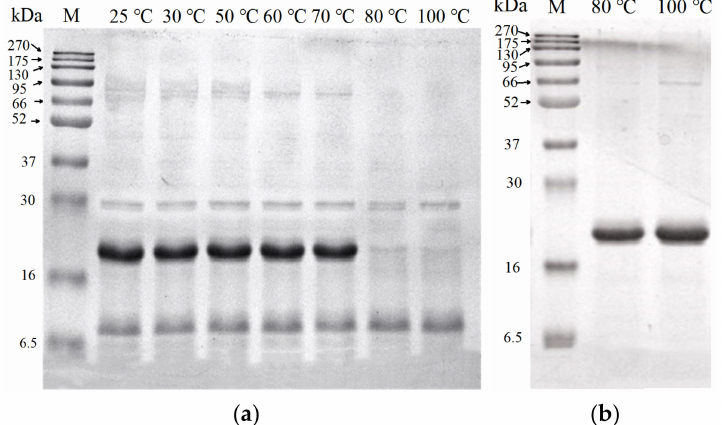
Figure 3. SDS-PAGE analysis of heated primary pigment proteins. ( a ) After heating at 25 to 100 ◦ C for 10 min. ( b ) The precipitate of primary pigment proteins after heating at 80 and 100 ◦ C for 10 min. (Lane M indicates the protein